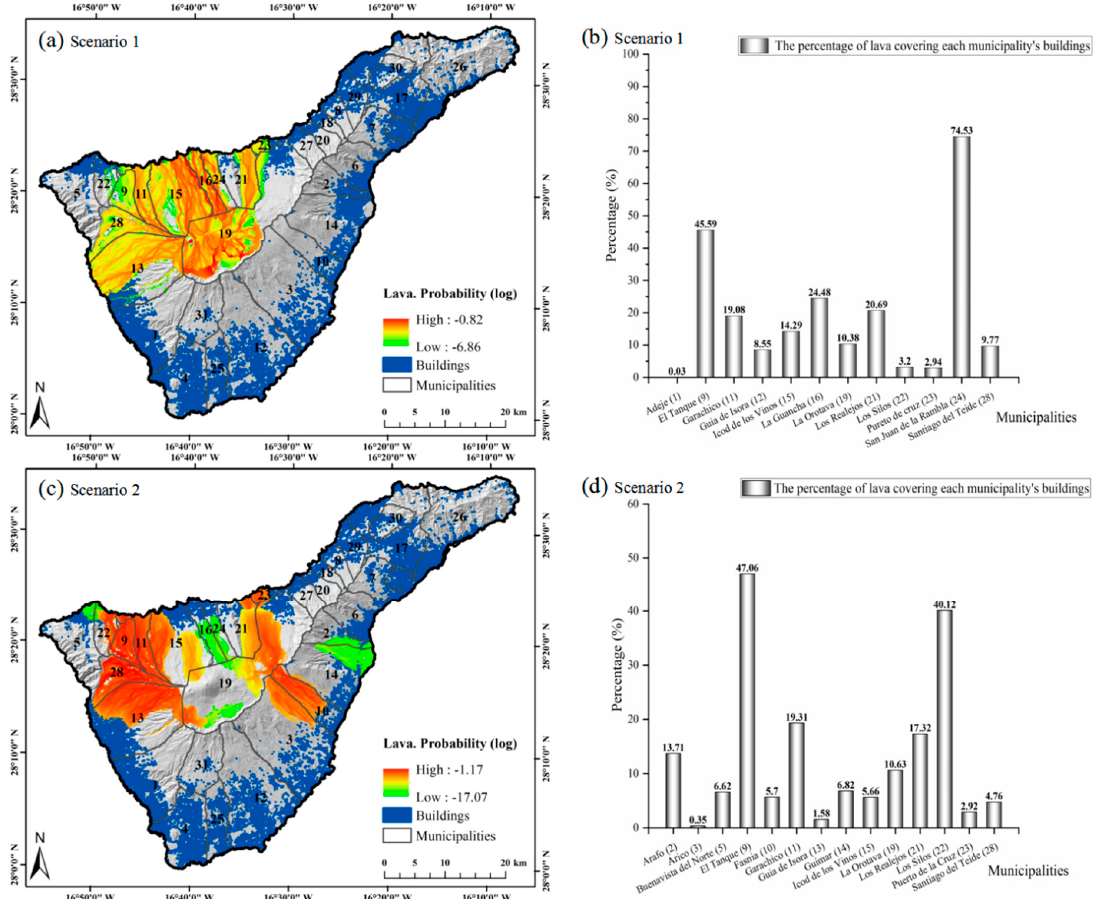
Figure 6. ( a ) The distribution of simulated lava flows in Scenario 1. ( b ) The percentage of lava covering each municipality’s buildings in Scenario 1. ( c ) The distribution of simulated lava flows in Scenario 2. ( d ) The percentage of lava covering each municipality’s buildings in Scenario 2. For the reader’s convenience, the number labels (see Table 1) are always placed after the place names in the